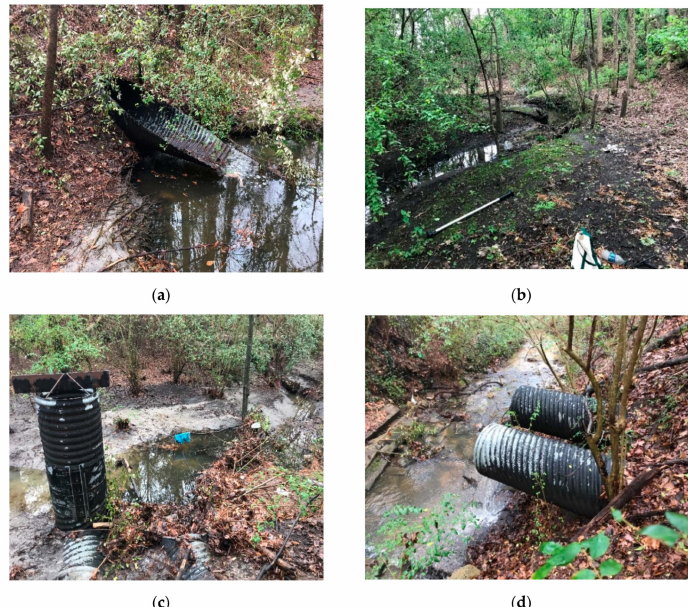
Figure 2. Dry detention basin inlet ( a ), interior ( b ), outlet structures ( c ) and discharge pipes ( d ) to Reedy Branch. Photographs were captured by the